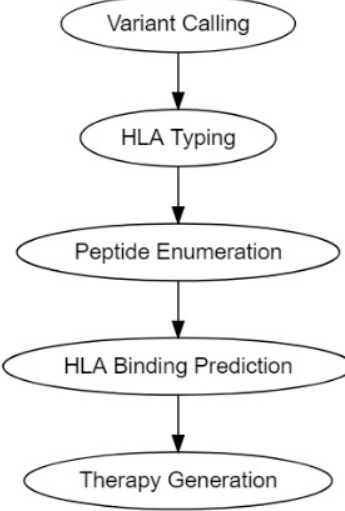
Figure 2. Tumor antigen computational pipelines.